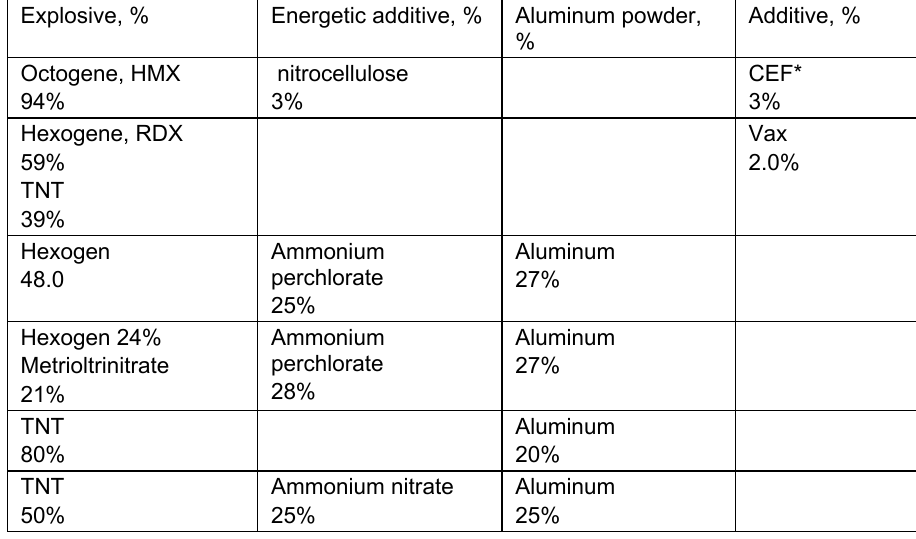
Table 2 – Compositions of the explosives used (An đ elkovi ć -Luki ć , 2015a,2015b) Таблица 2 – Составы используемых взрывчатых веществ (An đ elkovi ć -Luki ć